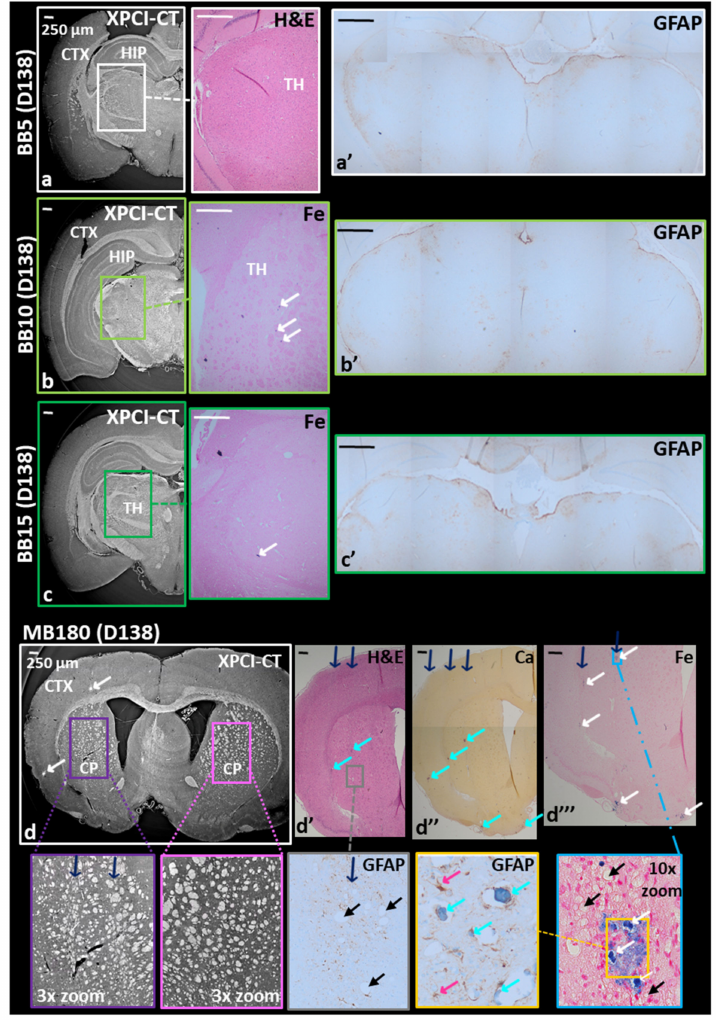
Figure 2. BB and MB180 healthy treated samples. Coronal XPCI-CT images are compared with histology and immunohistochemistry analysis. When the entire slice is not displayed, only the irradiated hemisphere of the brain is reported. ( a ) Shows an XPCI-CT image for the treated side of the BB5 brain reporting no damages in the cortex (CTX), hippocampus (HIP) and thalamus (TH) as confirmed by its H&E and GFAP ( a’ ) stained corresponding tissue slices. The BB10 sample is analyzed in ( b ) and ( b’ ), where just small Fe deposits are present and marked in blue (see white arrows) in the Fe-stained histology. The GPAF slice reports small reagent uptake in both the hemispheres thus, no RT-induced lesions are revealed. Subfigures ( c – c’ ) report a BB15 sample analysis where the three different investigations do not show significant pathology: only a small Fe sediment is visible. GFAP staining reveals discrete reactive gliosis in both the hemispheres. MB180 sample display RT-induced scars along the beam path that are visible in XPCI-CT ( d ) especially in the caudate putamen (CP) of the right-side brain and in its 3 × zoom together with the left-side counterpart. By this comparison, a reshape in the nervous structures is illustrated along the MB peak delivery areas (indicated by the blue arrows). Subfigures ( d’ – d”’ ) and their insets report the presence of Ca and Fe minerals within the MB-driven scar indicated by cyan and white arrows, respectively together with cell-loss findings displayed as bubbles in the tissue (black arrows) and small astrocytes next to the calcifications. All the images are displayed in the radiological